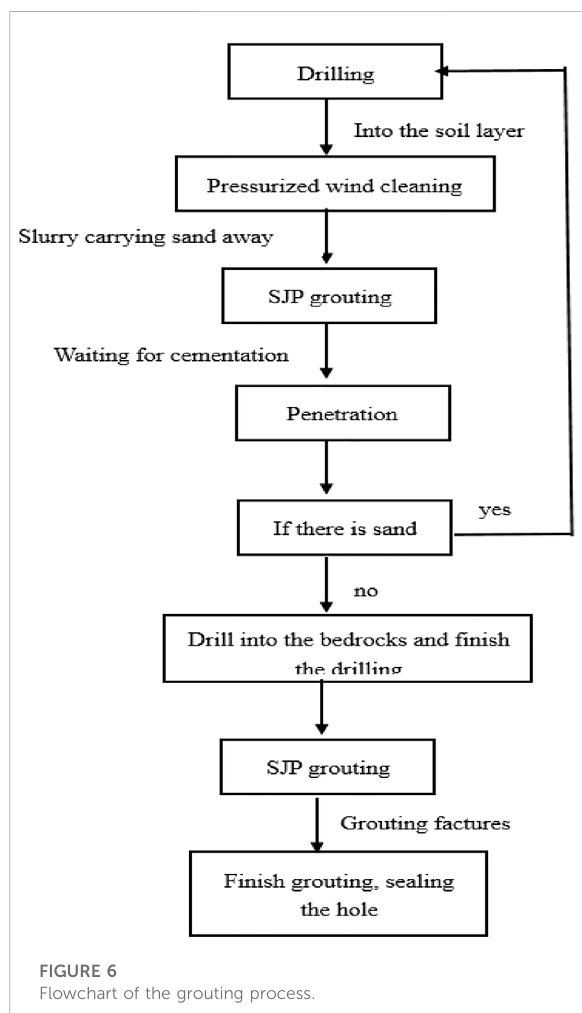
FIGURE 6 Flowchart of the grouting